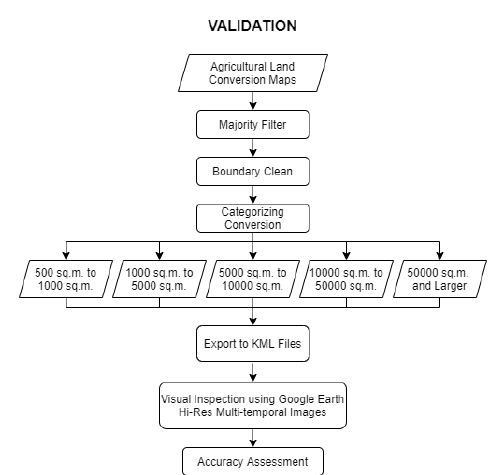
Figure 3. General Methodology – Validation